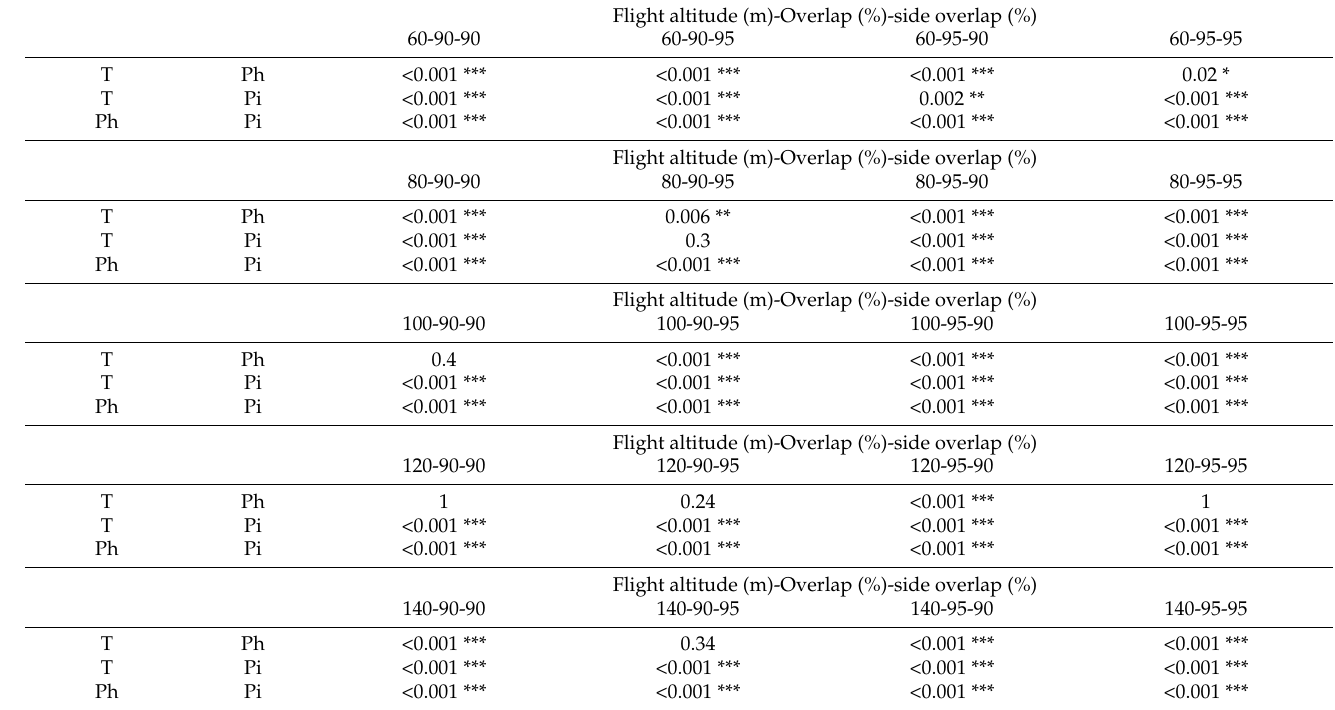
Table 5. Results of multiple comparisons of estimated tree height between different software.